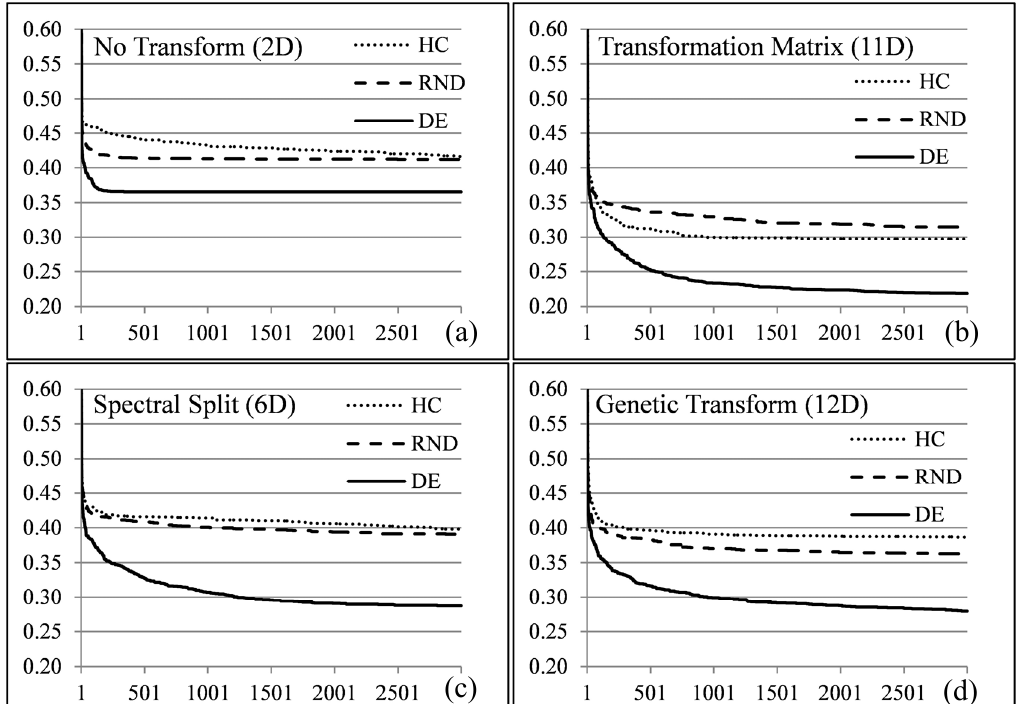
Figure 14. Fitness traces for three search methods on the Jowhaar site (SLIC segmentation) using the ( a ) No Transform, ( b ) Transformation Matrix, ( c ) Spectral Split and ( d ) Genetic Transform transformation strategies. The x-axes delineate search iterations. The y-axes delineate RWJ evaluation